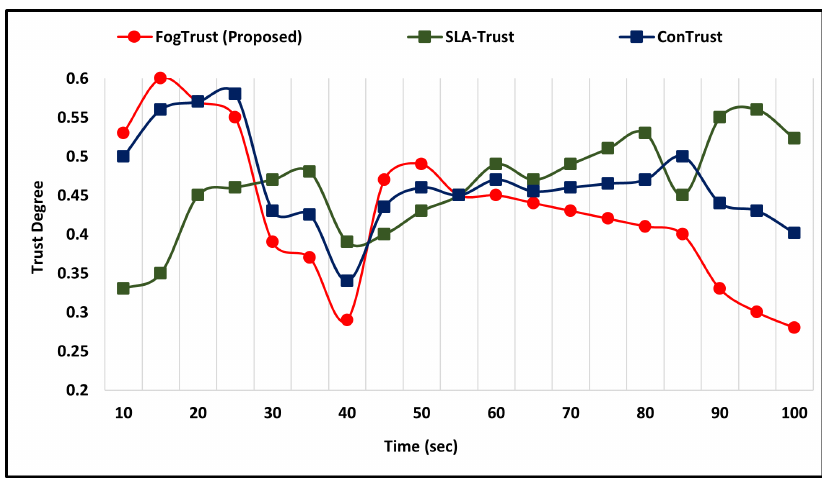
Figure 5. Comparative Analysis Against Good-Mouthing